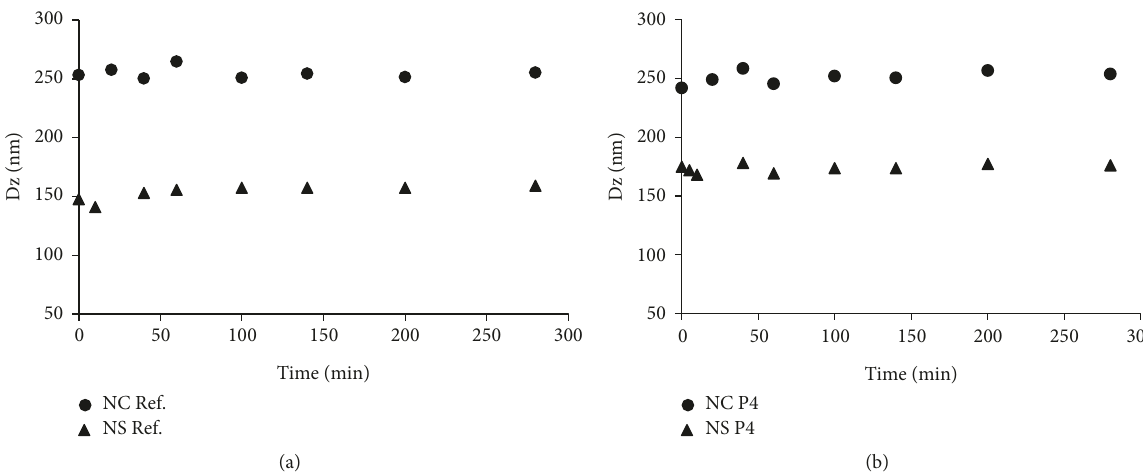
Figure 2: TEM micrographs of PMMA (a) nanospheres and (b) nanocapsules, both using 1 mg